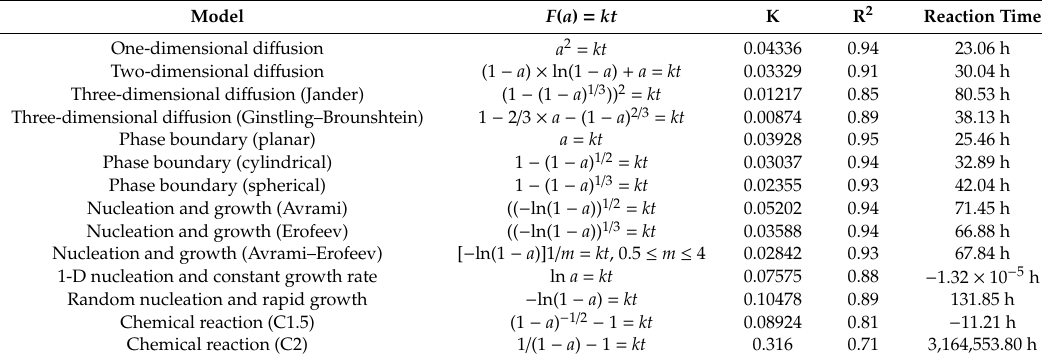
Table 1. Kinetics models usually employed for solid-state